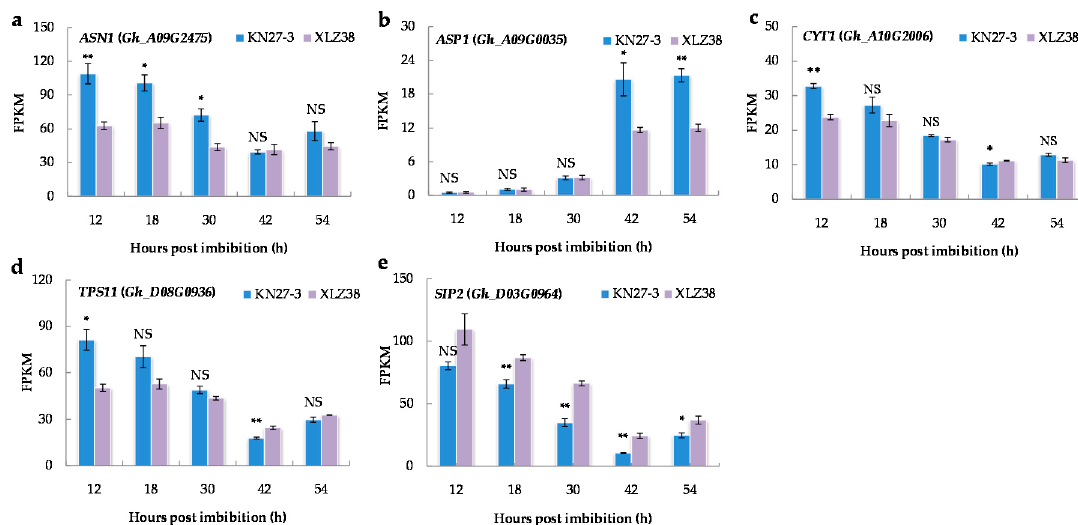
Figure 5. Major DEGs related to osmoregulation. ( a ) ASN1 , ( b ) ASP1 , ( c ) CYT1 , ( d ) TPS11 , ( e ) SIP2 . Values are the FPKM means of three independent replicates ± SE. Bars marked with asterisks indicate di ff erences change between the same hour (* p < 0.05, ** p < 0.01) according to Duncan’s multiple range test using SPSS software. “NS” represents no di ff